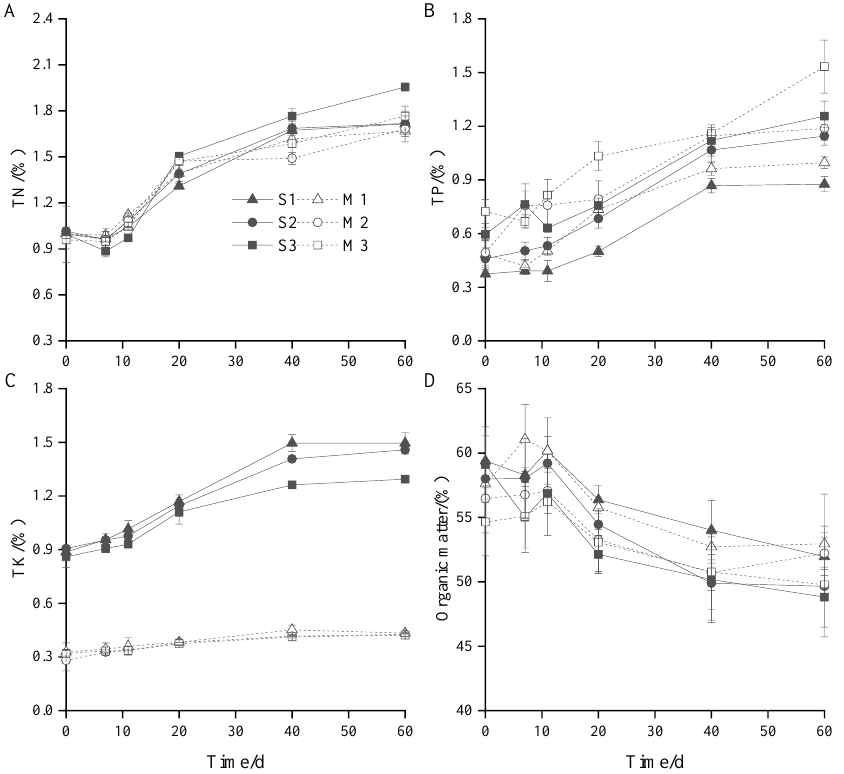
Figure 3. Variation in TN( A ), TP( B ), TK( C ), and organic matter( D ) during composting. S1: pig manure + straw; S2: pig manure + straw + 3% SSP; S3: pig manure + straw + 6% SSP; M1: pig manure; M2: pig manure + 3% SSP; M3: pig manure + 6% SSP.